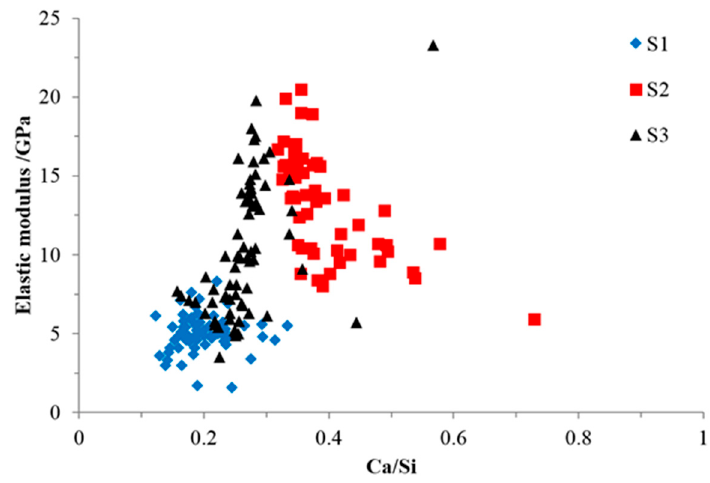
Figure 14. The relationship between elastic modulus and Ca/Si ratio.